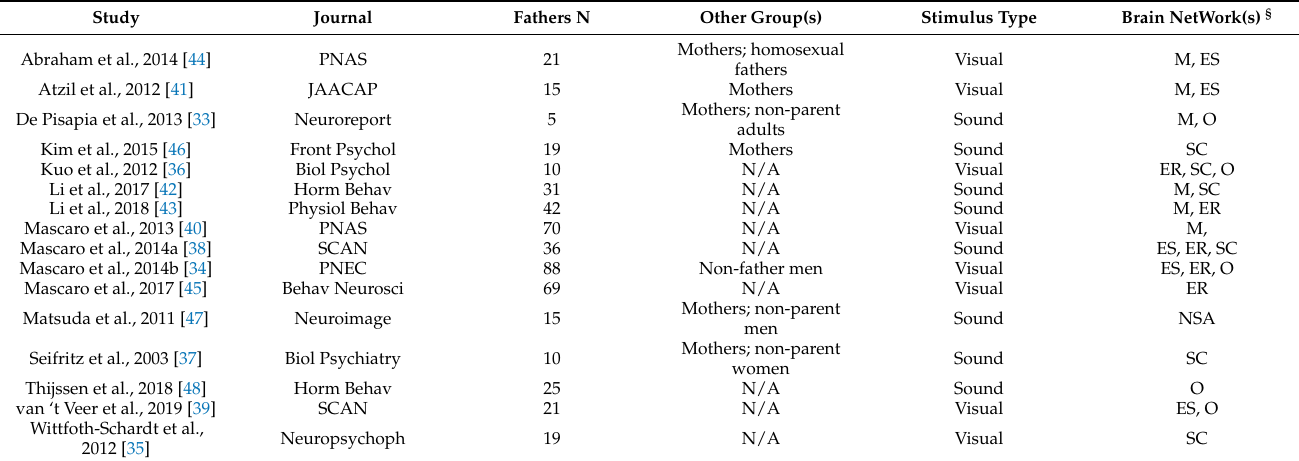
Table 1. Schematic description of the core characteristics of the included